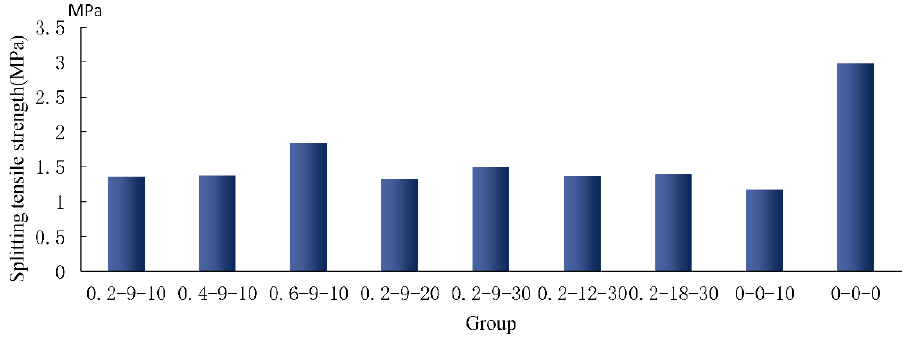
Figure 4. Diagram of variation of the splitting tensile strength.